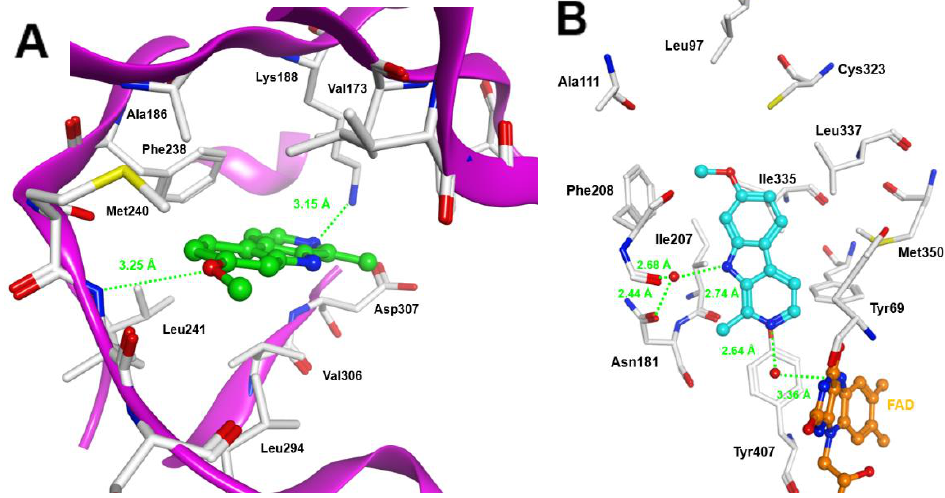
Figure 1. ( A ) Binding modes of harmine (carbon atoms colored in green) in DYRK1A (PDB 3ANR), and ( B ) harmine (carbon atoms colored light blue) in MAO-A (PDB 2ZGX). Hydrogen bonds are indicated by dashed green lines, water molecules as red balls. Distances are given in Å.